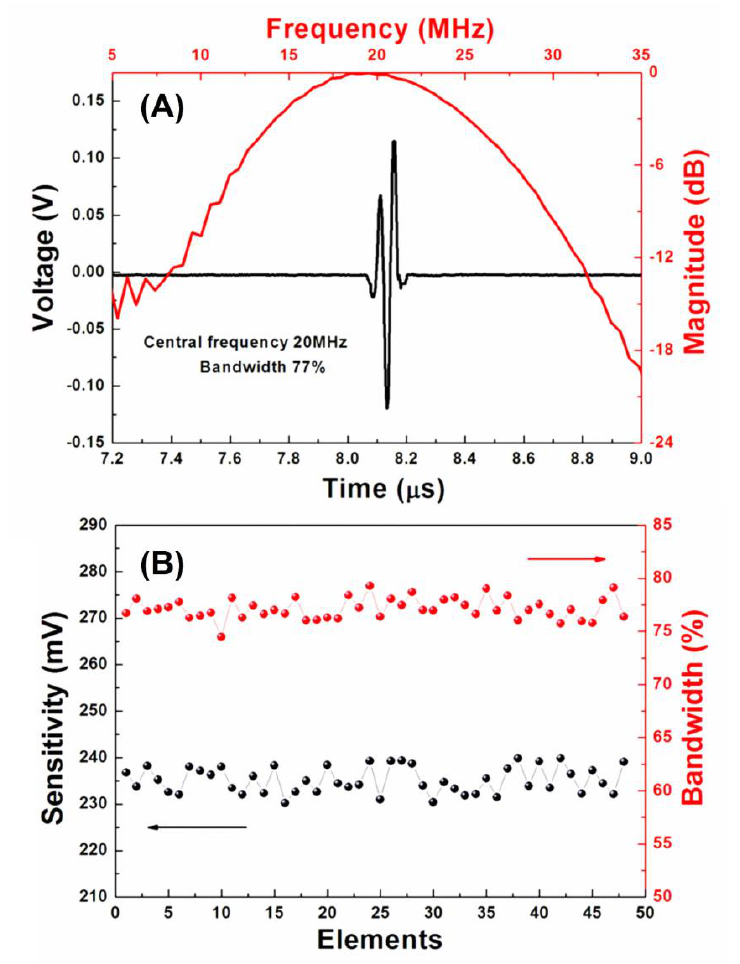
Figure 5. ( A ) Measured pulse-echo response performance of random element; ( B ) sensitivity and bandwidth of the pulse-echo signal for each